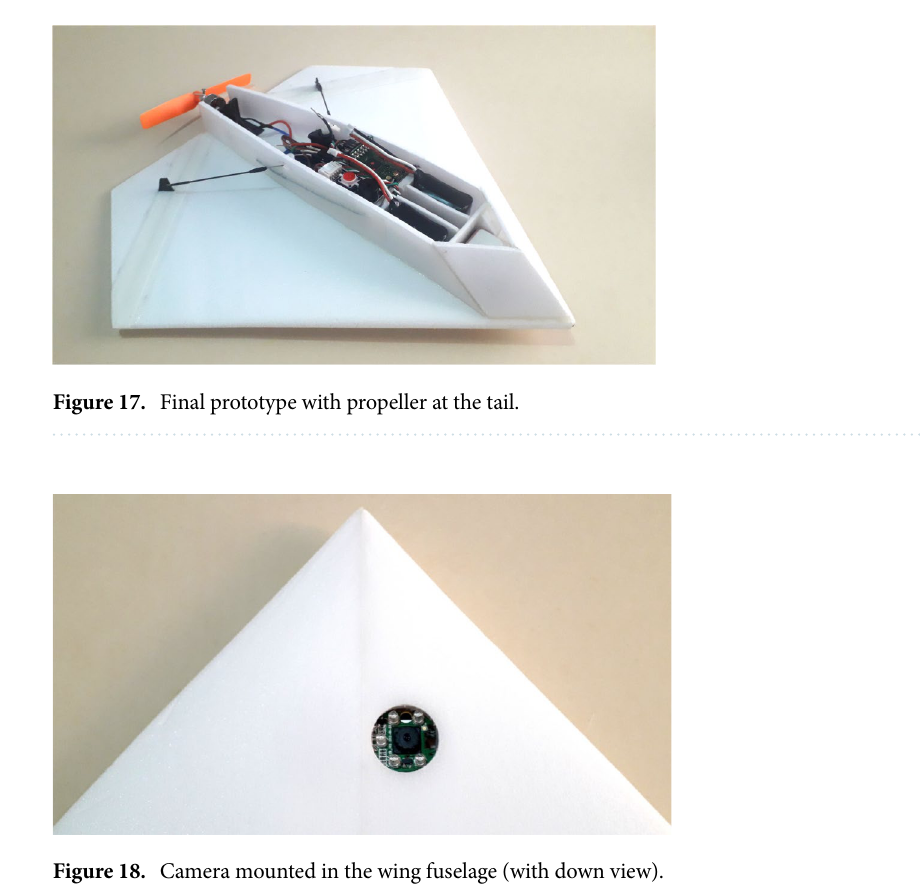
Figure 18. Camera mounted in the wing fuselage (with down view).